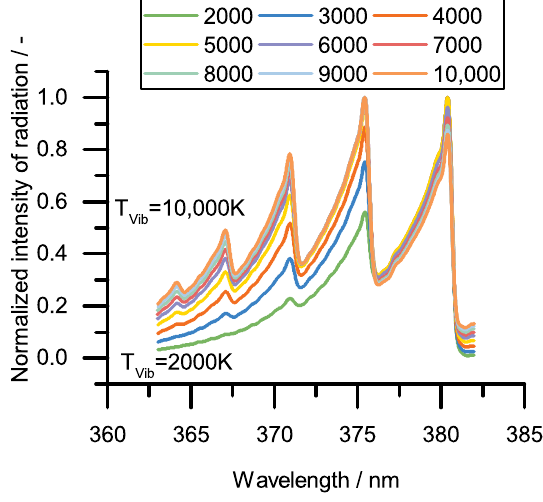
→ B 3 , 𝛥 v = − 2 at various u g ∏ ∏